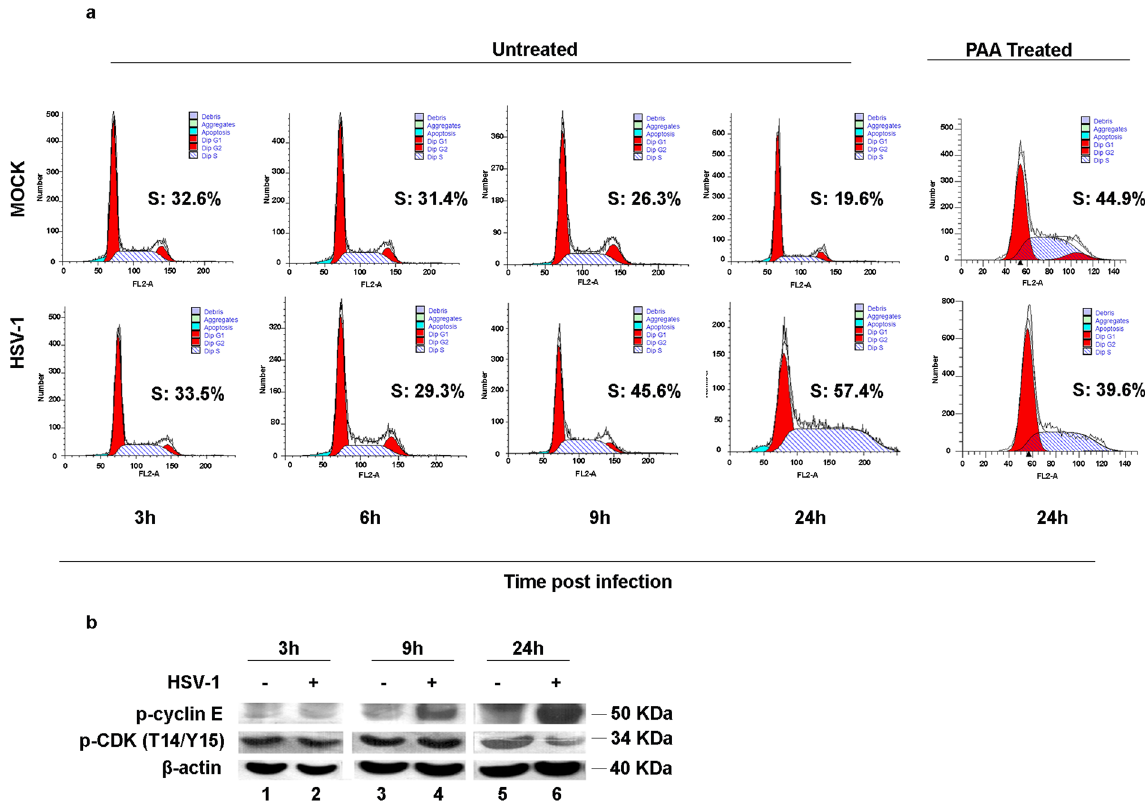
Figure 1. Cell cycle analysis and expression of p-cyclin E and p-CDK in HEp-2 cells during HSV-1 infection. ( a ) HEp-2 cells were mock infected or infected with HSV-1 at MOI 10, and collected at 3, 6, 9 and 24 h p.i. At 24 h cells were infected or mock infected incubated in presence of DNA polymerase inhibitor phosphonoacetic acid (PAA). The cellular DNA content was determined at indicated times by FACS analysis as described in Methods. Processed cells were labelled with PI (10 µ g/ml) to calculate different phases of cell cycle. The data were analyzed as means of triplicate ± SD and the percentage of S-phase cells was obtained using ModFit LT 3.0 software. ( b ) HEp-2 cells were mock infected or infected with HSV-1 at MOI 10 and collected at 3, 9 and 24 h p.i. for proteins extraction. Equal amount of proteins were separated by polyacrylamide gel electrophoresis and probed with phospho-cyclin E (Thr 395)-R and phospho-CDK (T14/Y15) antibodies. β -actin was used as a loading